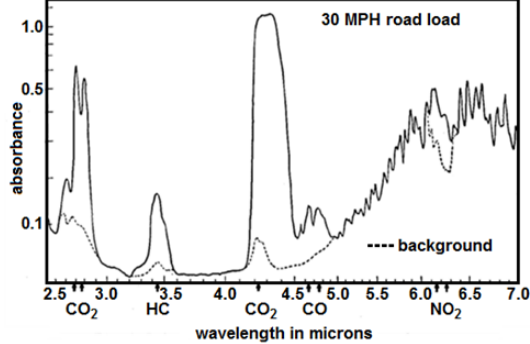
Fig. 9. Absorption spectrum for exhaust gases of motor vehicles – pre- pared basing on [8]